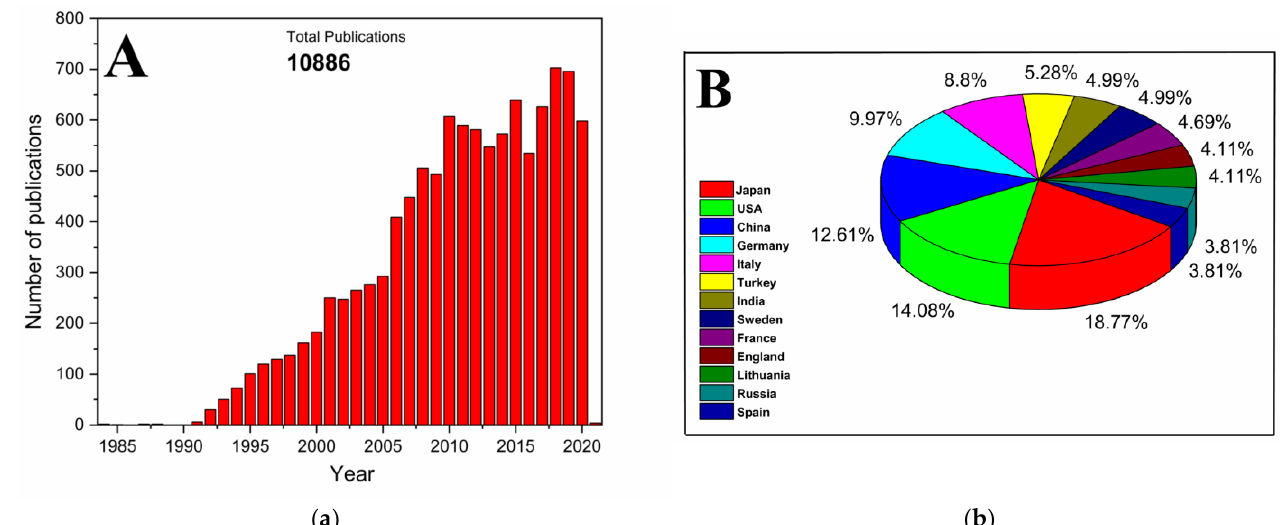
Figure 4. ( A ) Evaluation based on a literature search of the Web of Science database for publications regarding ethanol biofuel cells over the past 40 years and ( B ) publications about ethanol biosensors per country: search conducted in November/2020 at webofknowledge.com.